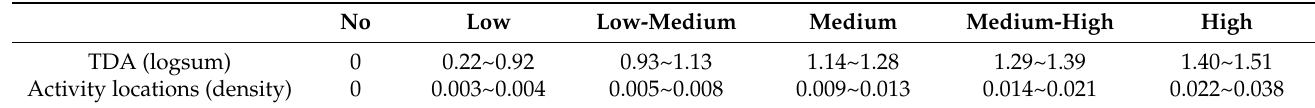
Table 7. TDA and urban activity location